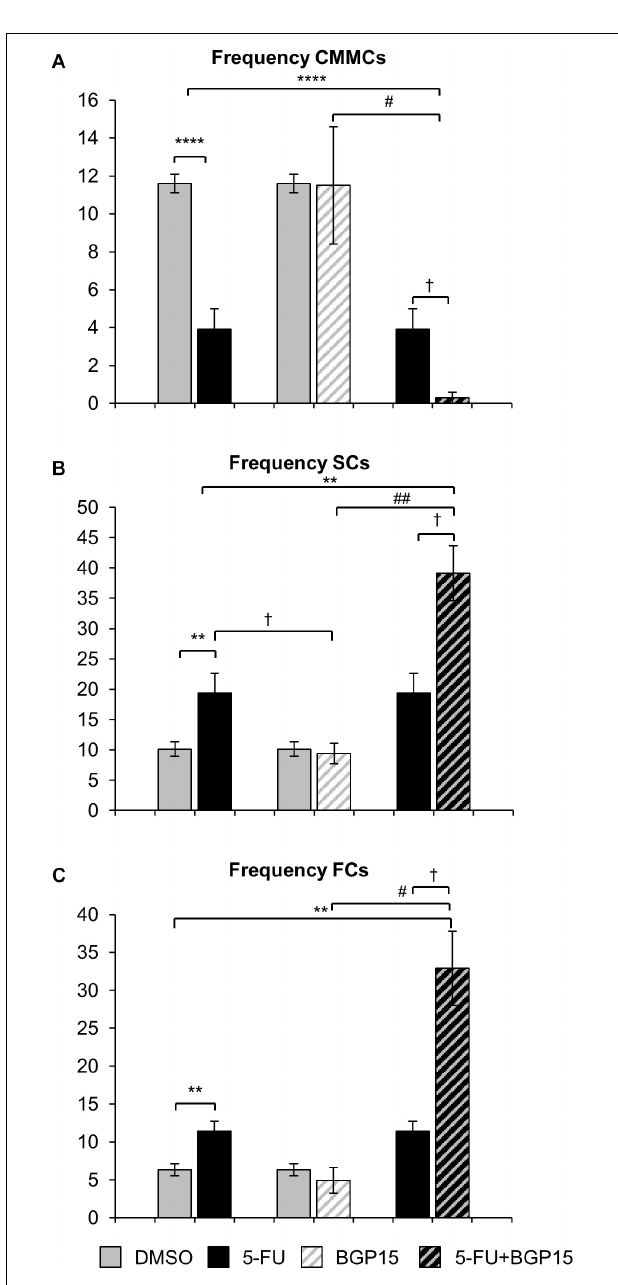
FIGURE 5 | Frequency of different contractions following repeated in vivo 5-FU ± BGP-15 administration. Number of CMMCs per 15 min in the colons from DMSO, 5-FU, BGP-15, and 5-FU+BGP-15 administration (A) . Number of SCs per 15 min in the colons from DMSO, 5-FU, BGP-15, and 5-FU+BGP-15 administration (B) . Number of FCs per 15 min in the colons from DMSO, 5-FU, BGP-15, and 5-FU+BGP-15 administration (C) . Data represented as mean ± SEM. ∗∗ P < 0.01, ∗∗∗∗ P < 0.0001 significantly different to DMSO group. † P < 0.05 significantly different to 5-FU group. # P < 0.05, ## P < 0.01 significantly different to BGP-15 ( n = 5 mice/group).